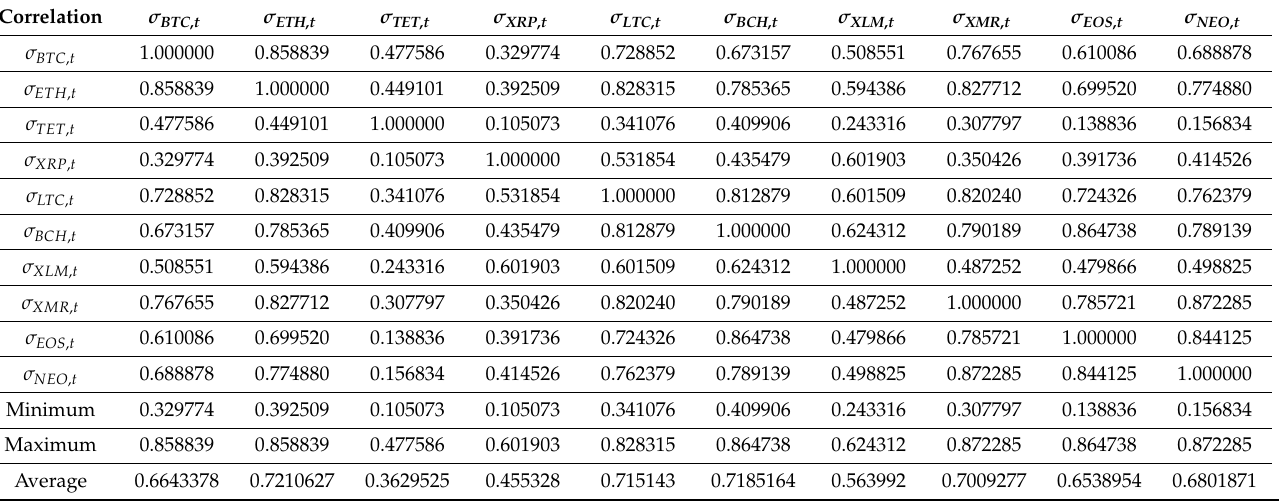
Table 12. Correlations among the varying GARCH values of the 10 cryptocurrencies’ return indices for the COVID-19